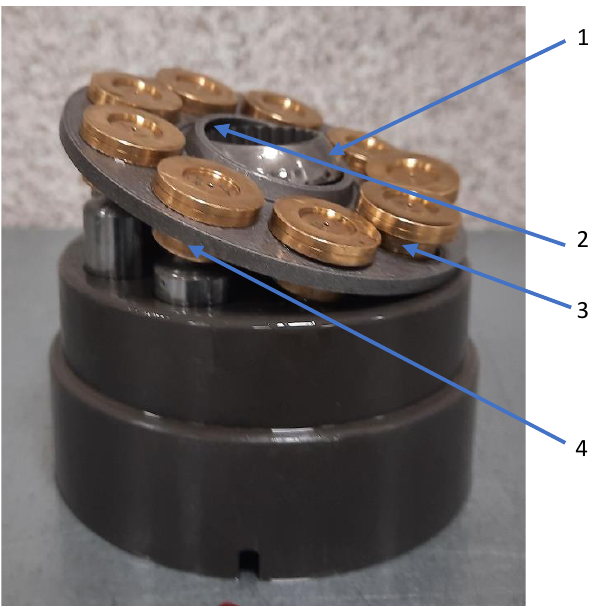
Figure 7. Four tested pump parts subjected to wear analysis: 1 — spherical retainer guide; 2 — spherical surface in the slipper-retainer; 3 — the conical surface of the 1st piston; 4 — the conical surface of the 2nd piston.